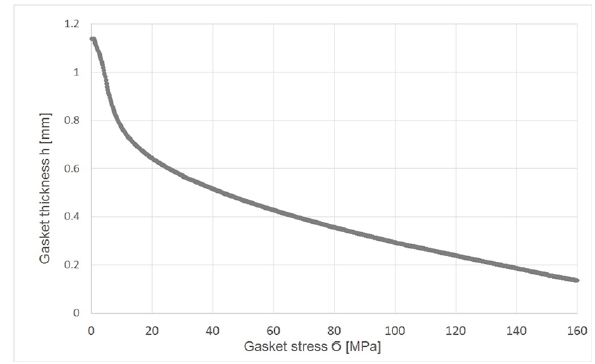
Figure 10: Compression characteristics of compressed expanded